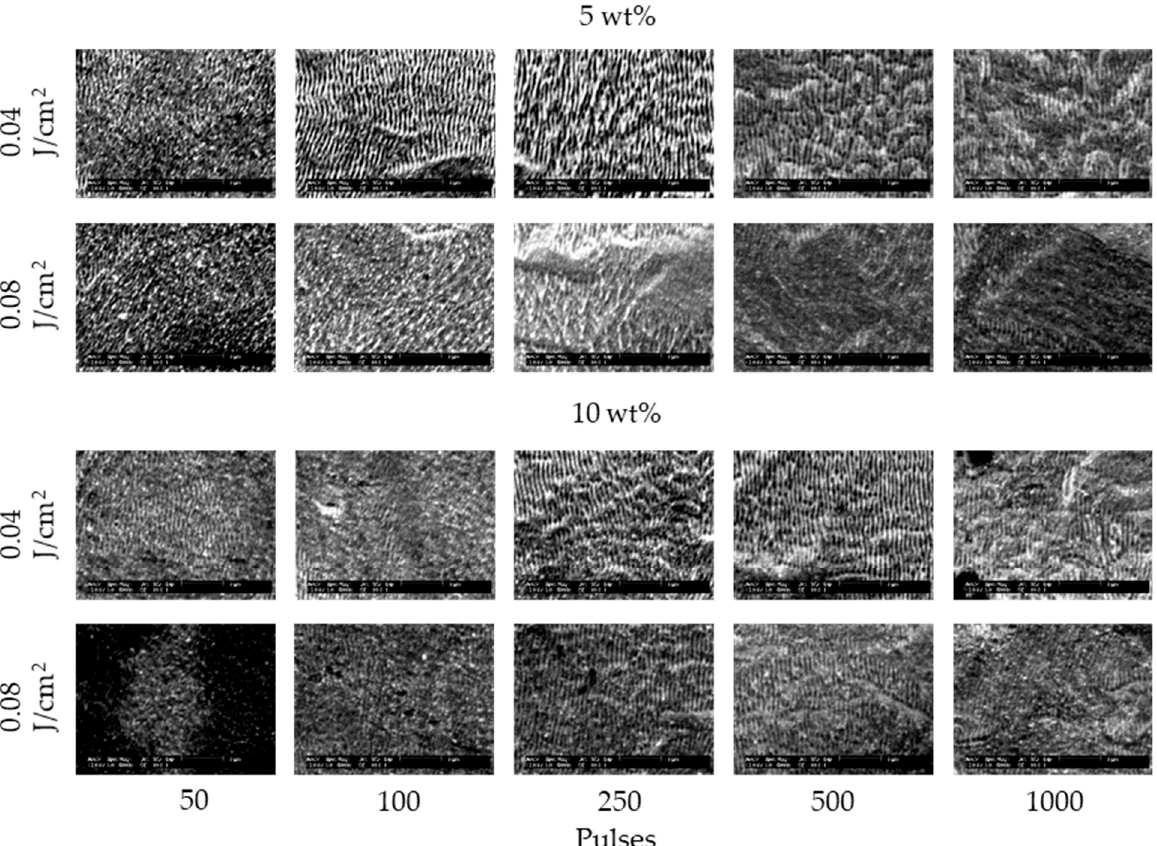
Figure 4. SEM images of 304 stainless steel irradiated with N = 50–1000 pulses at F = 0.04–0.08 J/cm 2 in 5 and 10 wt% NaCl solutions. The laser beam has the polarization in a lateral direction.